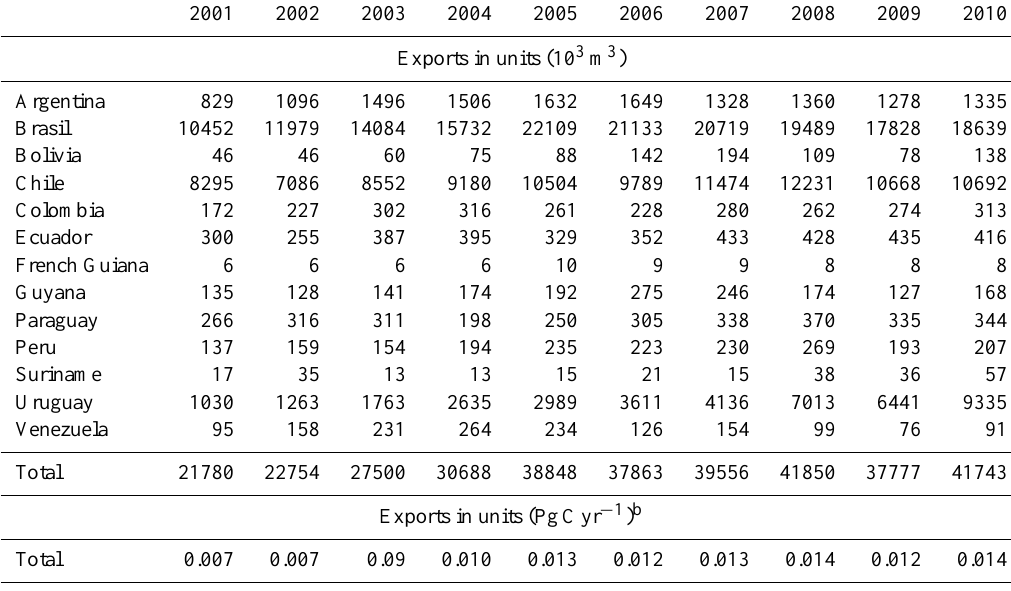
Table 9. Export of wood and wood products a .